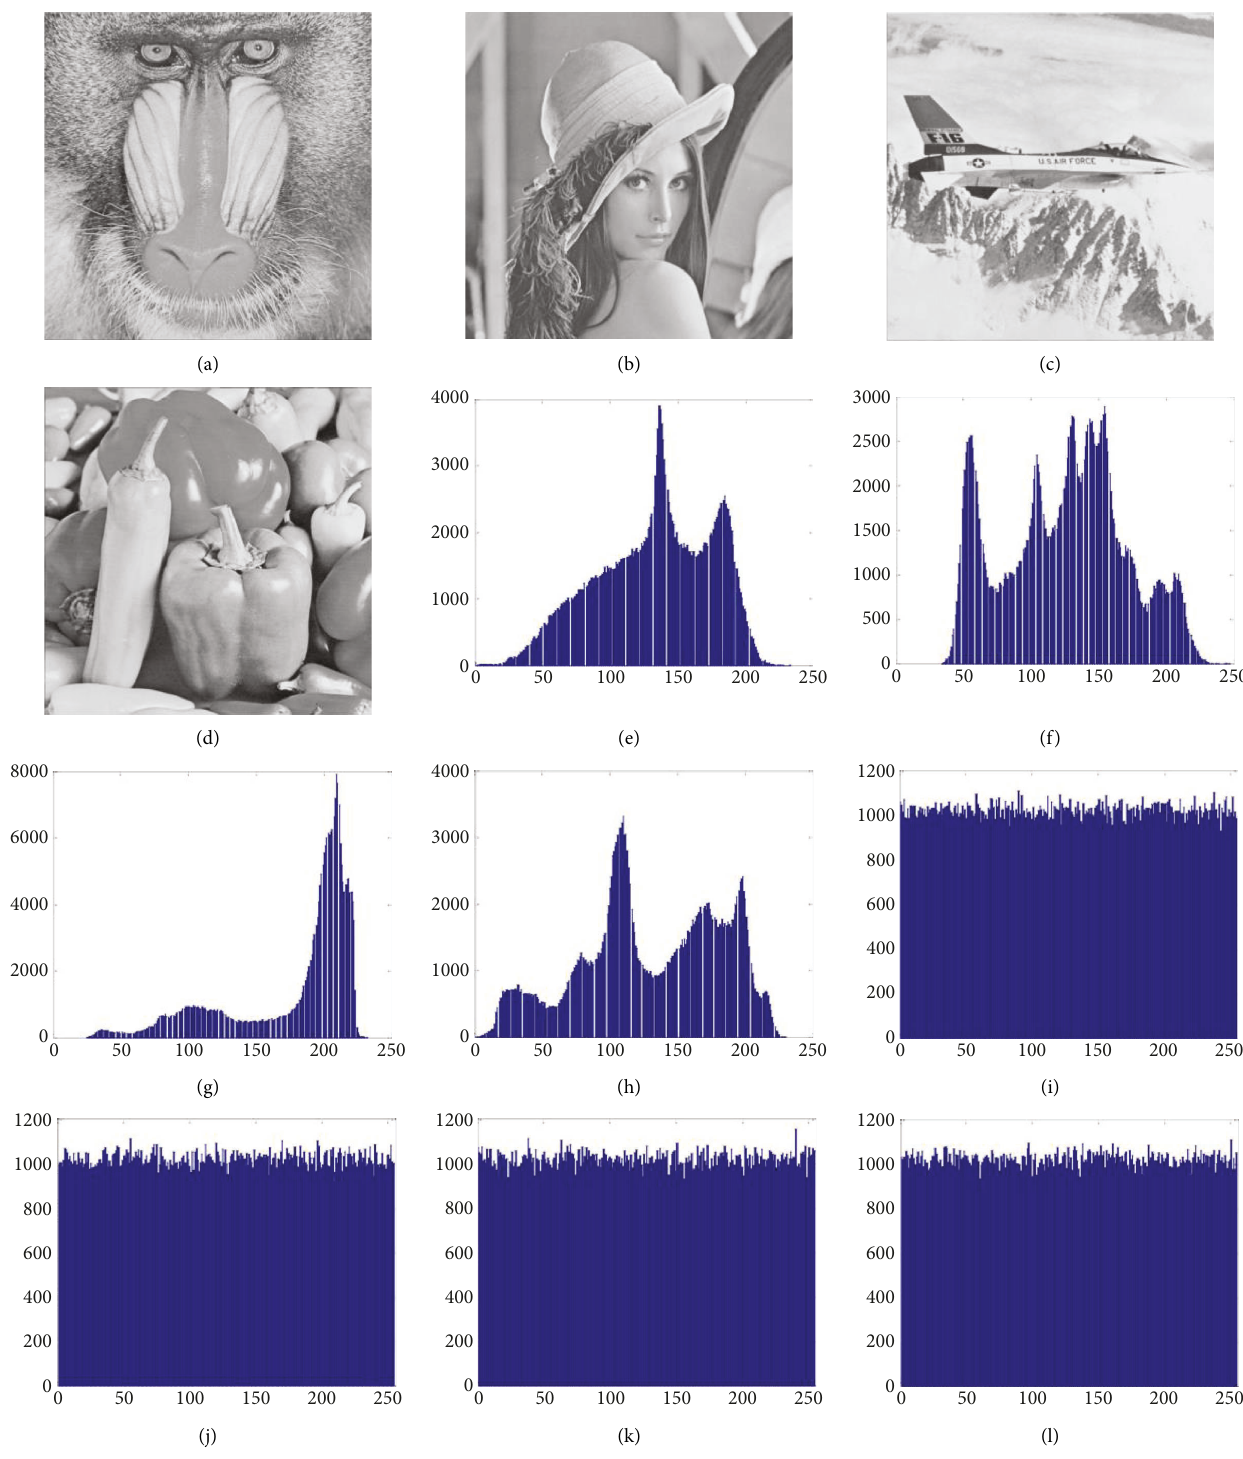
Figure 5: Histograms of original plain images (e)-(h) and encrypted images (i)-(l); (a)-(d) the original